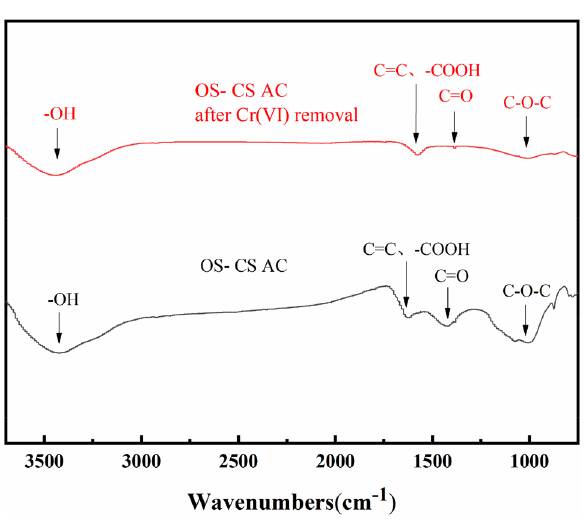
Figure 6. Pore volume curve of ( a ) OS-CS AC and ( b ) OS-CS AC after removal of Cr(VI).